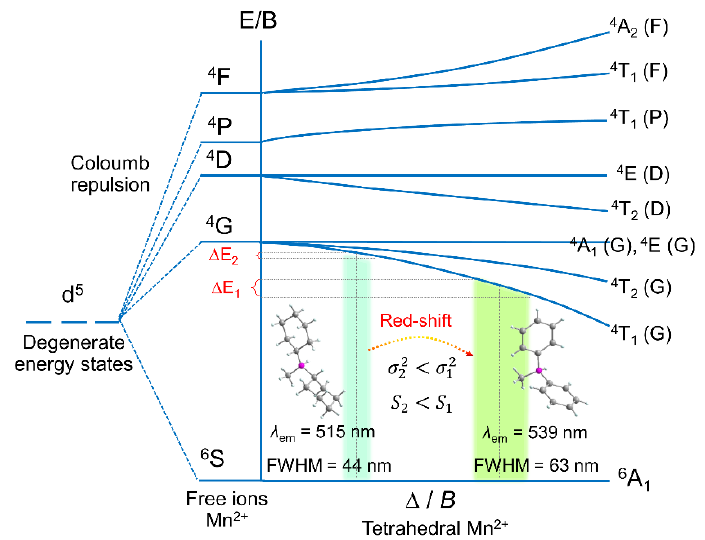
Figure 5. Tanabe–Sugano energy-level diagram of Mn 2+ ions in tetrahedral crystal field.